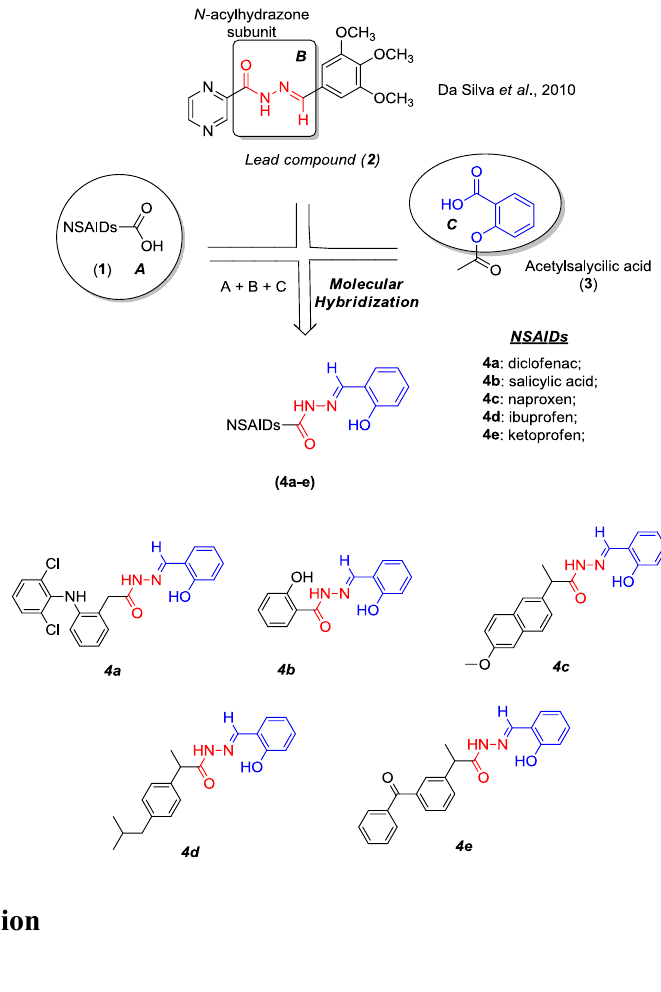
Figure 2. The first stage of the production of the NSAID derivatives involved two synthetic